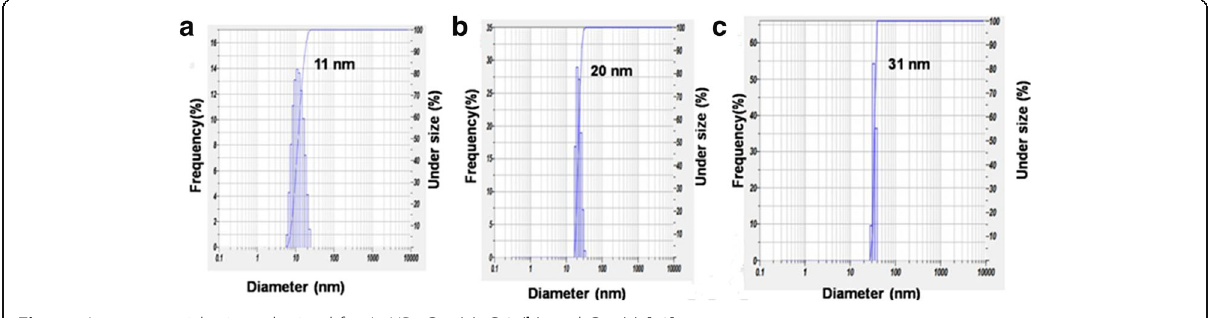
Fig. 11 Average particle sizes obtained for AgNPs Ct1 ( a ), Ct3 ( b ), and Ct4 ( c )